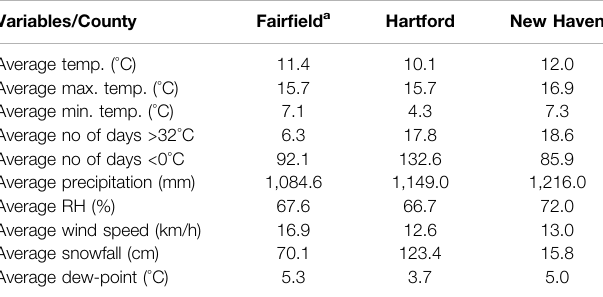
TABLE 2 | Summary of the historical climatic data of averages up to 50-years record in the